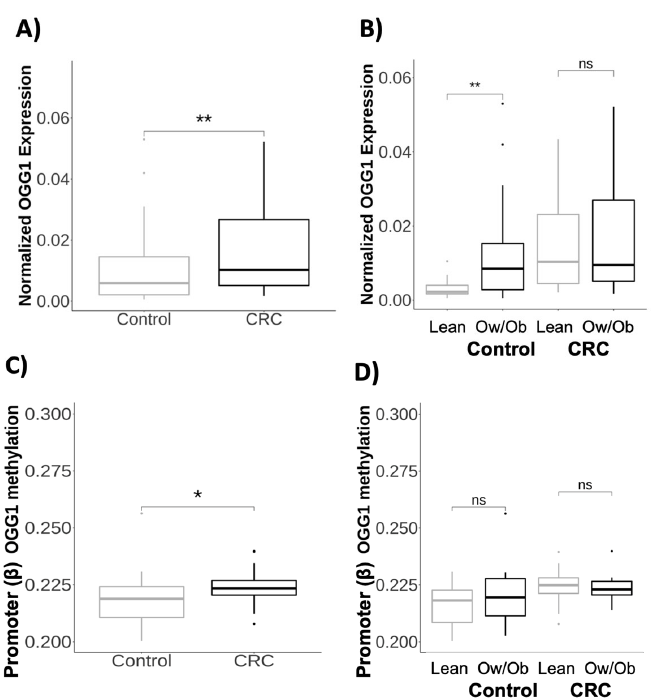
Figure 1. Gene expression and methylation profile of OGG1 in visceral adipose tissue from patients with obesity and colorectal cancer: ( A ) Normalized gene expression of OGG1 comparing healthy participants (N = 54) and patients with CRC (N = 65). ( B ) Normalized gene expression of OGG1 comparing healthy lean participants (N = 13) with overweight/obese participants (N = 41). In addition, we compared lean (N = 22) and overweight/obese patients with CRC (N = 43). ( C ) Promoter methylation of OGG1 comparing healthy participants (N = 24) and patients with CRC (N = 23). The promoter contained the following CpG sites: cg11841349, cg14201528, cg15357639, cg17285536, cg17319894, cg19391888, cg25415932, and cg05439191. ( D ) Promoter methylation of OGG1 comparing healthy lean participants (N = 7) with overweight/obese participants (N = 17). In addition, we compared lean (N = 11) and overweight/obese patients with CRC (N = 12). Gene expression was normalized using the PPIA gene and the formula: 2 −Δ Ct . Abbreviations: CRC: colorectal cancer; OGG1: OGG1 8-oxoguanine DNA glycosylase 1; Ow/Ob: overweight/obese; ns: non-signi fi cant. As- terisks indicate signi fi cant values according to the test (* p < 0.05; ** p < 0.01).